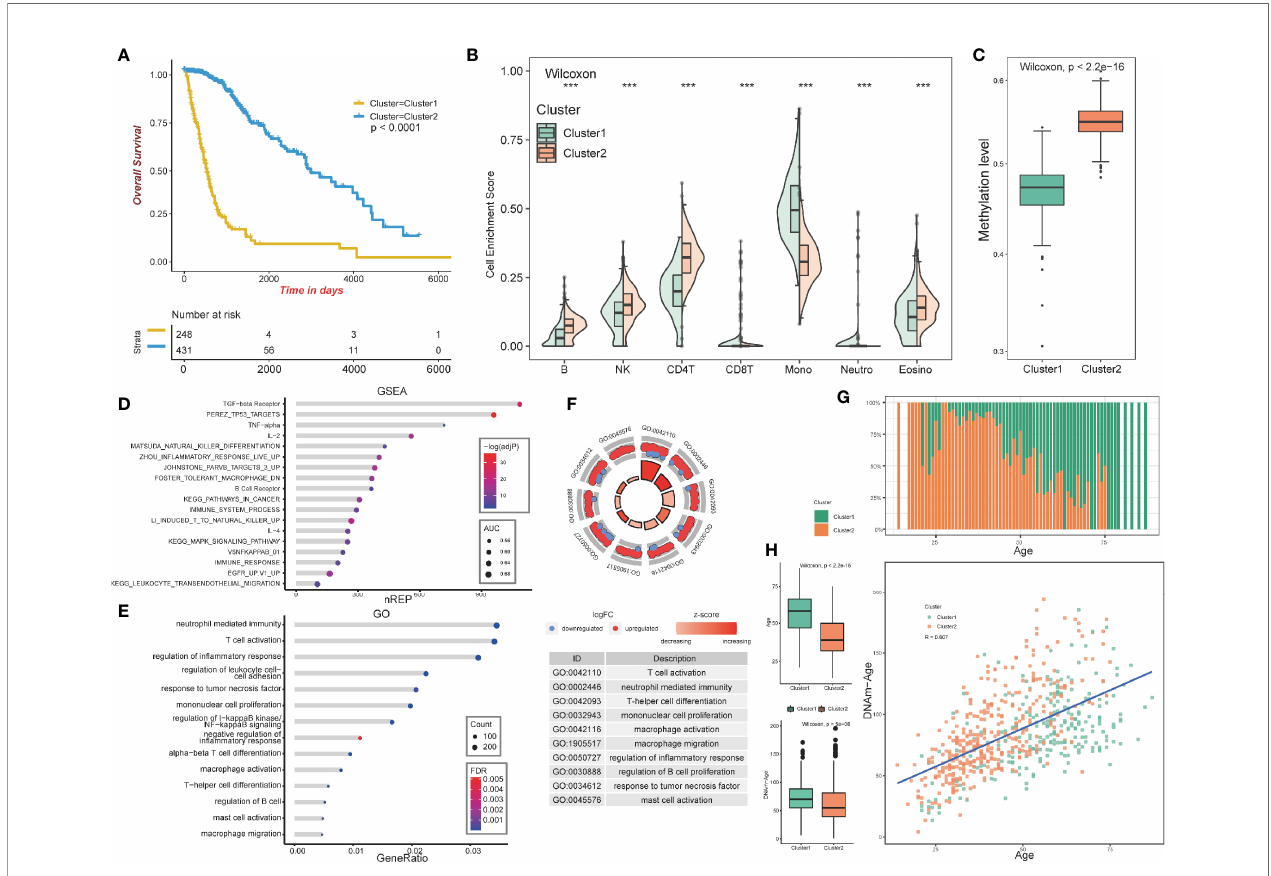
FIGURE 2 | Construction and analysis of consensus cluster. (A) Kaplan – Meier survival analysis of the two clusters showing clear separation. (B) Tumor-in fi ltrating immune analysis of the two clusters based on TCGA methylation set. (C) Methylation levels of the two clusters. (D) ebGSEA result of the two clusters. (E, F) GO functional enrichment analysis of the two clusters. (G) Age distribution of the two clusters. (H) Box plot showing the age and DNA methylation age difference between the two clusters, Scatter plot revealing correlations of the DNA methylation age-age correlation coef fi cients between cluster1 and cluster2. ***p